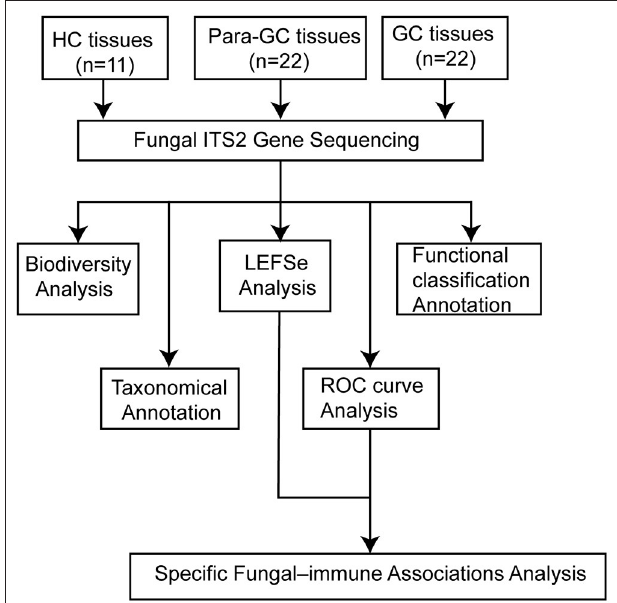
FIGURE 1 | This flowchart illustrates the conceptual framework for the proposed study. We totally enrolled 11 healthy controls (HC) and 22 patients with gastric cancer (GC), collecting the tissues for fungal internal transcribed spacer region 2 gene sequencing. Then, we compared the biodiversity among the three groups, obtained the taxonomic information at the phylum and genus level, used the linear discriminant analysis (LDA) effect size (LEFSe) and receiver operating characteristic (ROC) curve analysis to identify the different fungi, measured the relative mRNA levels of inflammatory factors, and performed the specific fungal-immune association analysis to find out the possible mechanism of fungal in GC. Finally, we used the FUNGuild to further predict the functional classification of the specific fungal